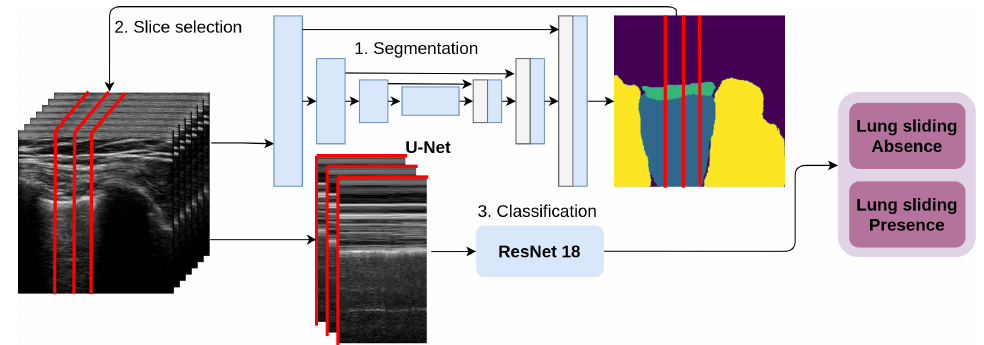
Figure 3. The architecture of the automated M-mode classification. 1. Segmentation of the tissue from a single LUS frame; 2. selection of a temporal slice based on the semantic segmentation; and 3. classification of the slices with a ResNet